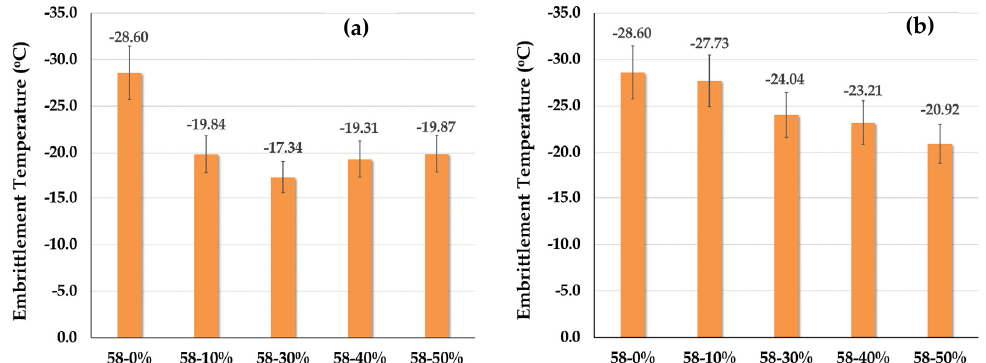
Figure 13. Embrittlement temperatures of PG58 ‐ 28 mixtures containing different amounts of RAP: ( a ) mixtures with partial blending of RAP and virgin binders, ( b ) mixtures with proper blending of RAP and virgin binders.